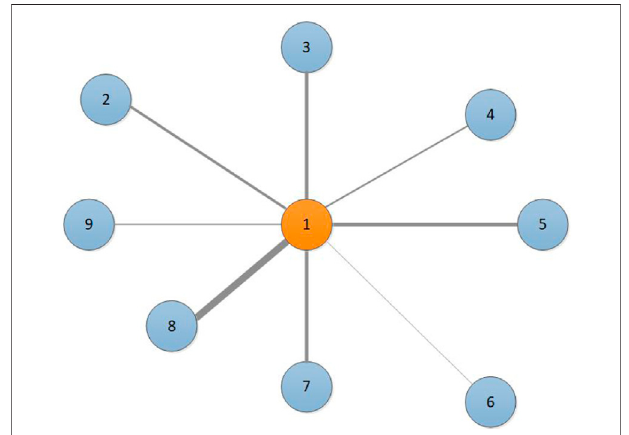
FIGURE 1 | The wind speed of the central site is affected by the wind from its surrounding site; the thickness of edges indicates the strength of the correlation.